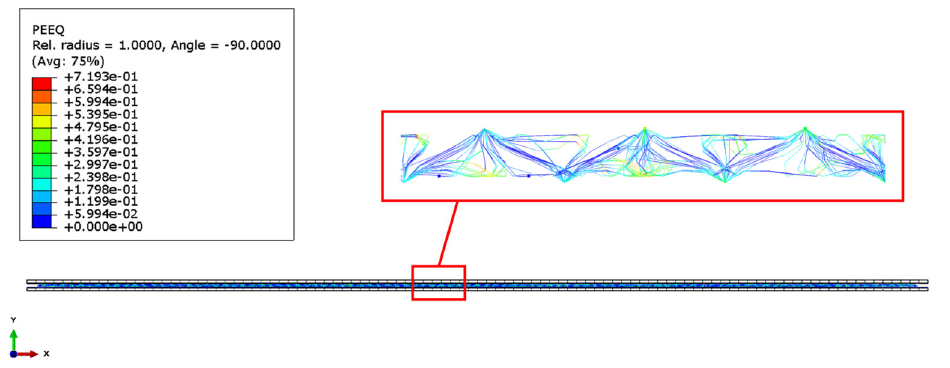
Figure 16. Plastic strain of the lattice part.